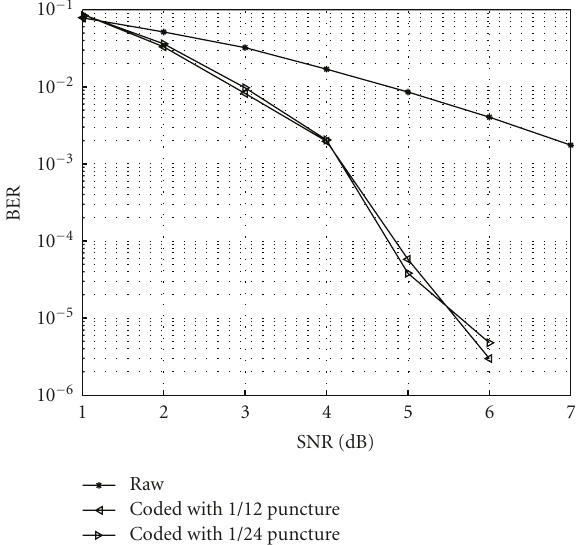
Figure 7: Average BER versus E b /N 0 for LO-MAC in Rician fading channel ( K = 12 dB, f d = 100 Hz).